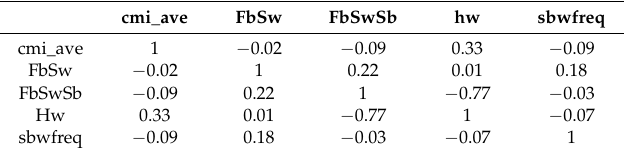
Table 1. Cross-correlations between explanatory variables. These variables are the average climate moisture index (cmi_ave); the percentages of the total basal area, that is, hardwood (hw), balsam fir and white spruce combined (FbSw), or balsam fir, white spruce and black spruce combined (FbSwSb); and the number of years of moderate–severe defoliation (sbwfreq).